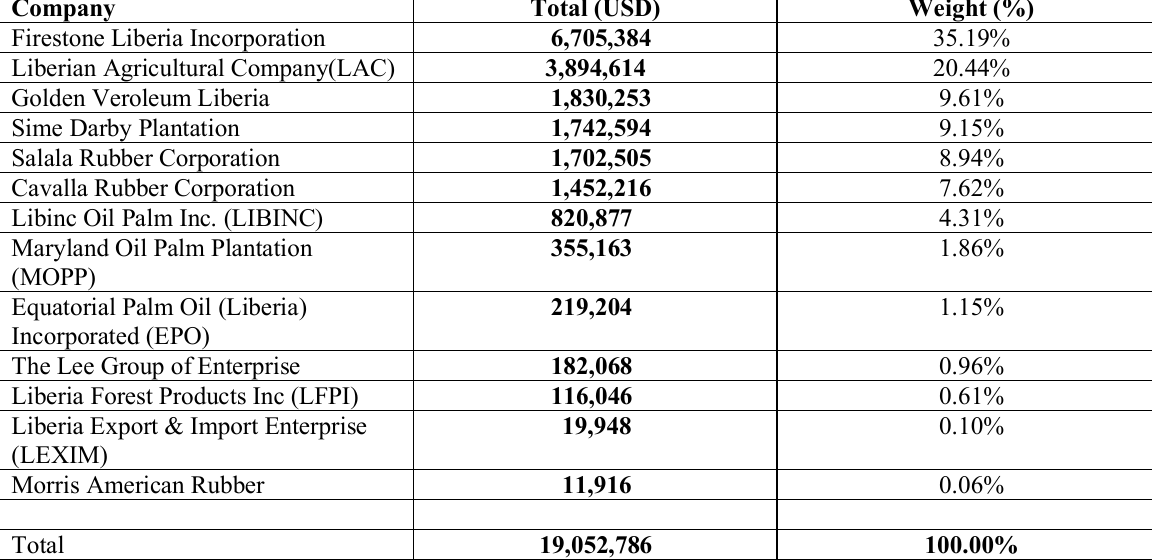
Table 2: Agricultural Companies Contributing to government's revenue (LEITI, 2016)